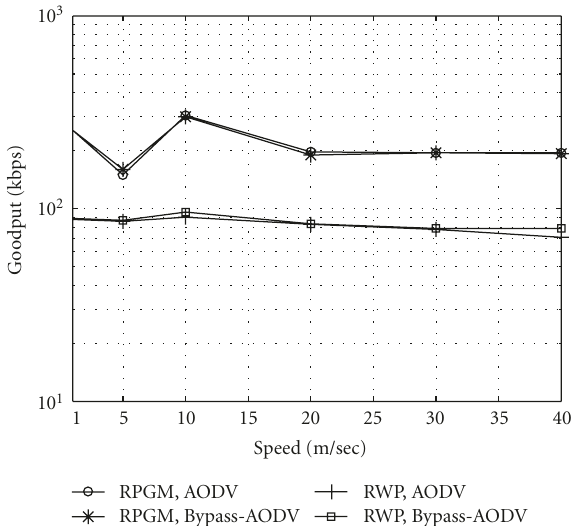
Figure 13: Routing overhead